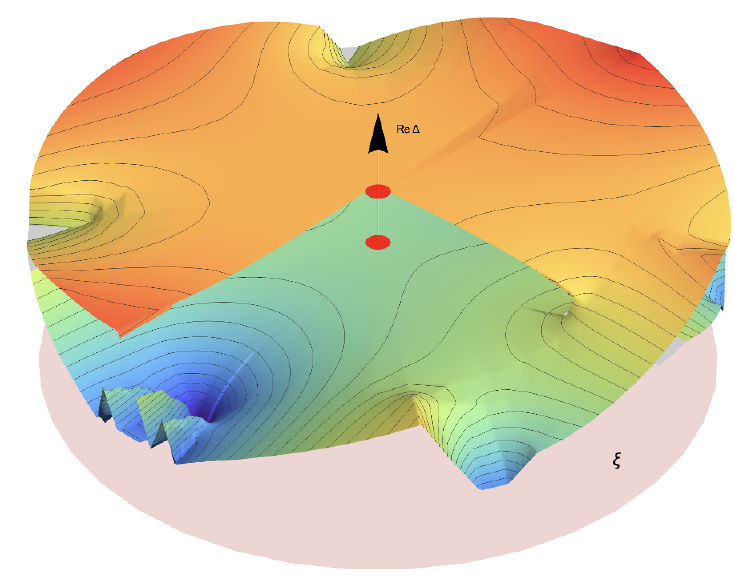
Figure 11 . Single magnon operator tr (cid:30) 3 (cid:30) 2 has a dimension (cid:1), which is a multivalued function 1 of (cid:24) . At weak coupling the bare dimension of the state is J 1 + J 2 = 4. Analytically continuing in (cid:24) one can discover an in(cid:12)nite tower of states with the bare dimensions 4 + 2 n; n = 0 ; 1 ; : : : ( n = 0 ; 1 are indicated by the red dots on the